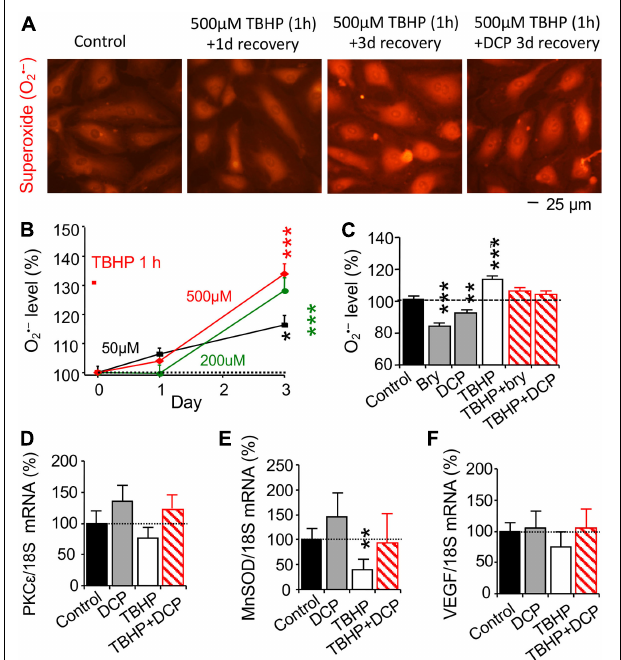
FIGURE 1 | The PKC ε activator prevents an increase in reactive oxygen species (ROS) and a decrease in MnSOD mRNA expression and increases PKC ε mRNA expression in human brain microvascular endothelial cells (HBMEC) treated with tert-butyl hydroperoxide (TBHP). (A) TBHP was used to induce mitochondrial dysfunction and an increase in reactive oxygen species (ROS), including superoxide (O 2 •− ). Cultured cells were treated with 0,